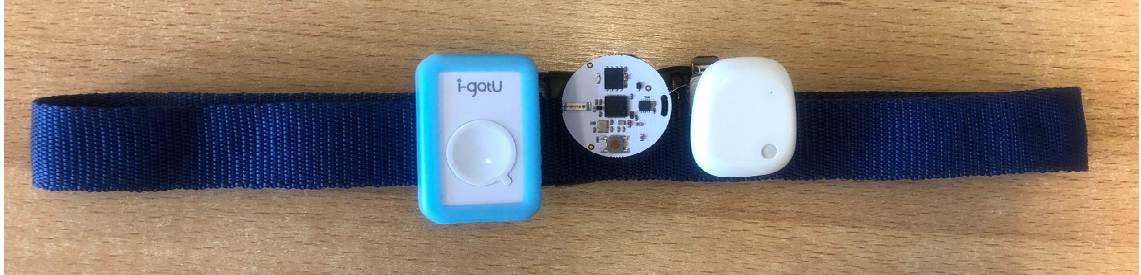
Figure 3. The proposed sensing system: GPS logger, proximity tag, MMR sensor (from left to right) mounted on a belt.